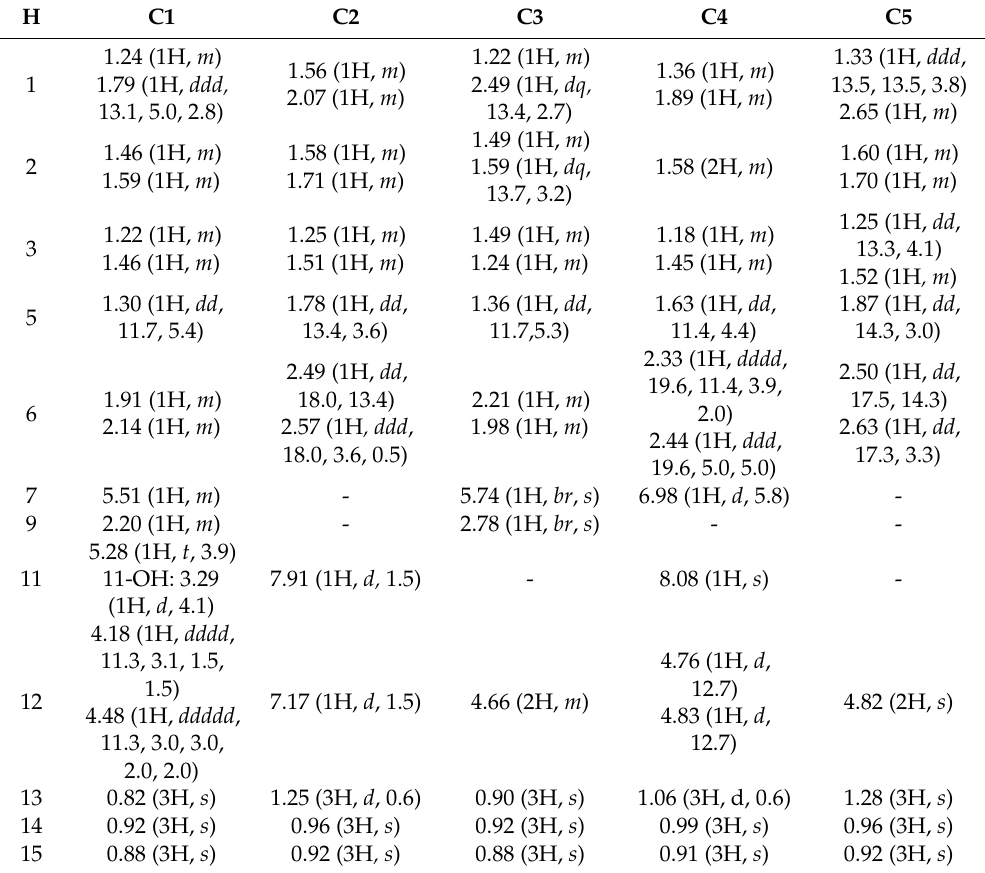
Table 1. 1 H-NMR (600 MHz, in CDCl 3. δ in ppm. J in Hz) results for sesquiterpenoids.